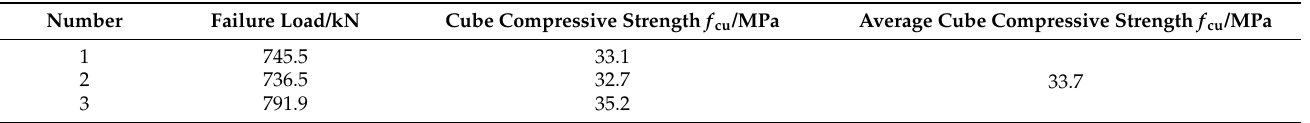
Table 3. Material properties of the concrete.